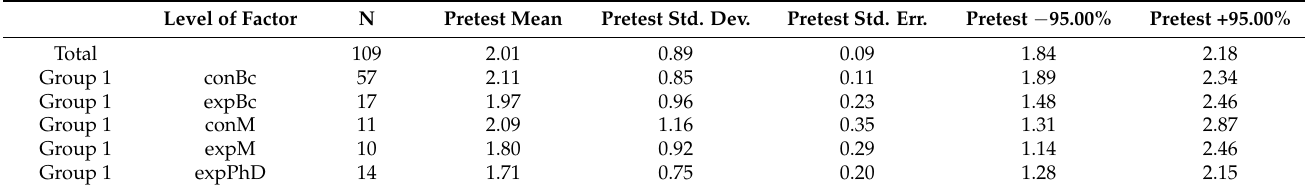
Table 6. Descriptive statistics for the pretest, taking into account the degree of study.